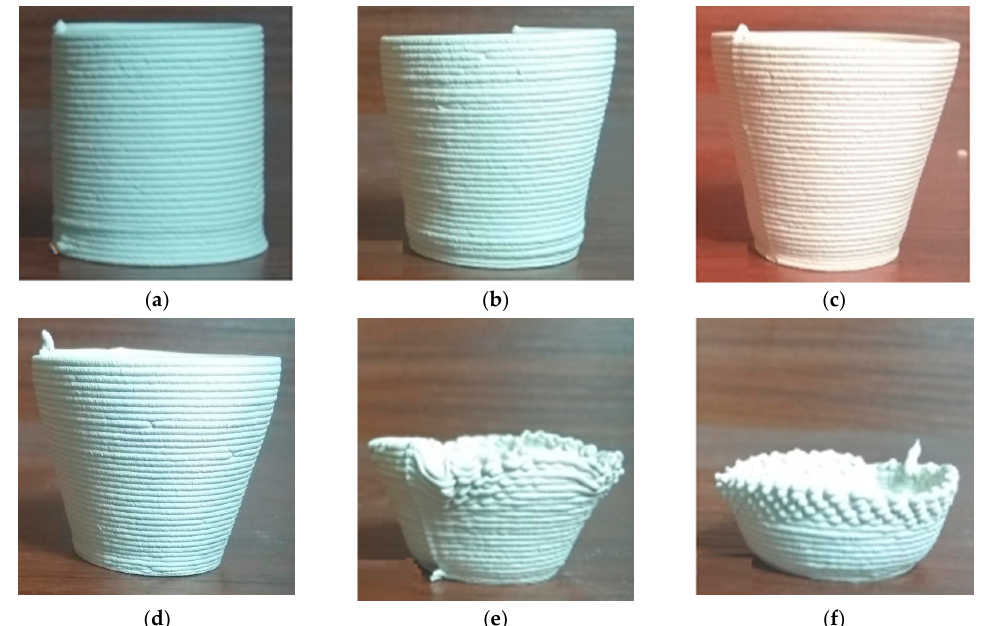
Figure 4. Conical thin-walled benchmark parts with layer height as 0.7d: ( a ) cone angle 0°, ( b ) cone angle 10°, ( c ) cone angle 15°, ( d ) cone angle 20°, ( e ) cone angle 25°, and ( f ) cone angle 30°.